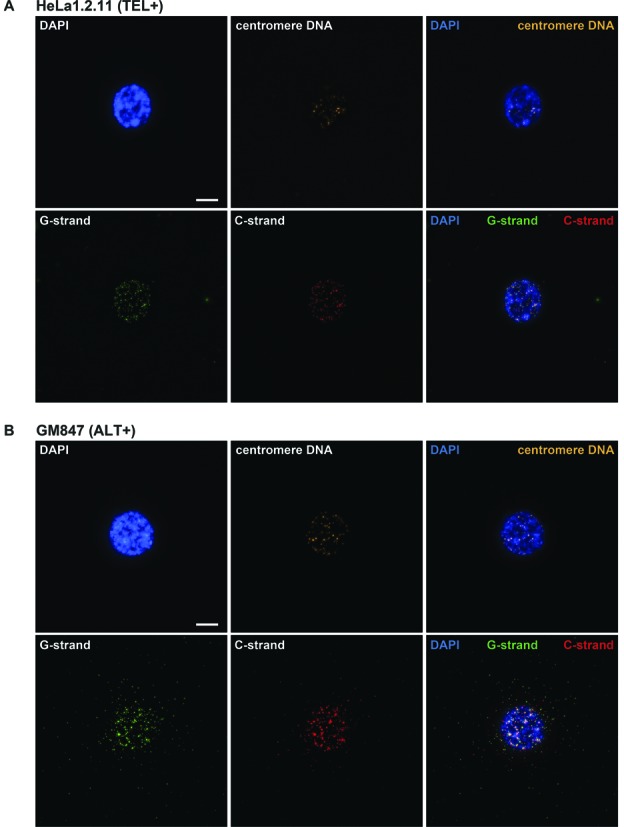
Representative images of human cells subjected to the Halo-FISH protocol. HeLa1.2.11 telomerase-positive cell (A) and GM847 ALT cell (B) are PNA probed for centromere DNA (orange), G-strand telomere-repeat DNA (green), C-strand telomere-repeat DNA (red) and counterstained with DAPI (blue). A set of 40 z-stack images were captured for each deproteinized nucleus at 0.2 μm intervals and were subjected to iterative deconvolution. TEL+: telomerase-positive, ALT+: ALT-positive. Scale bar, 10 μm.